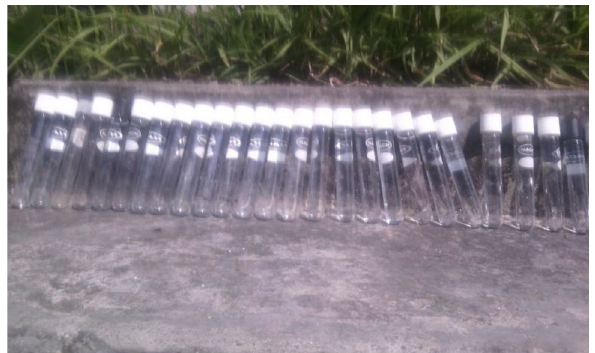
Fig. 1 Solar irradiation of water samples in the presence of Fe NPs